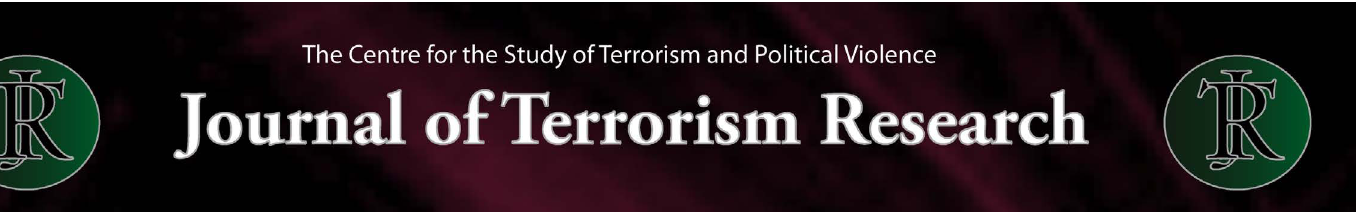
Table 2: Negative Binomial Model Results for PKK initiated Incidents Dependent Variable: